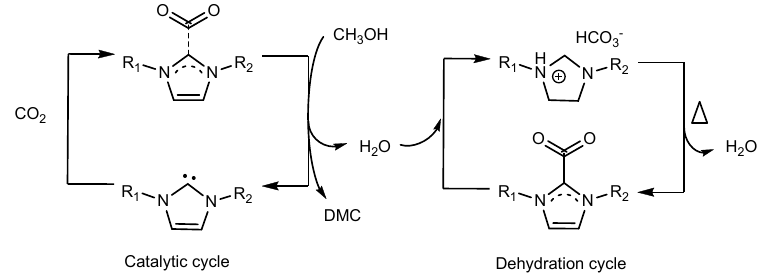
Figure 7. Catalytic and dehydration mechanism of [C n C m Im][HCO 3 ] [41]. (Reprinted/adapted with permission from Ref. [41], 2017, John Wiley and Sons)